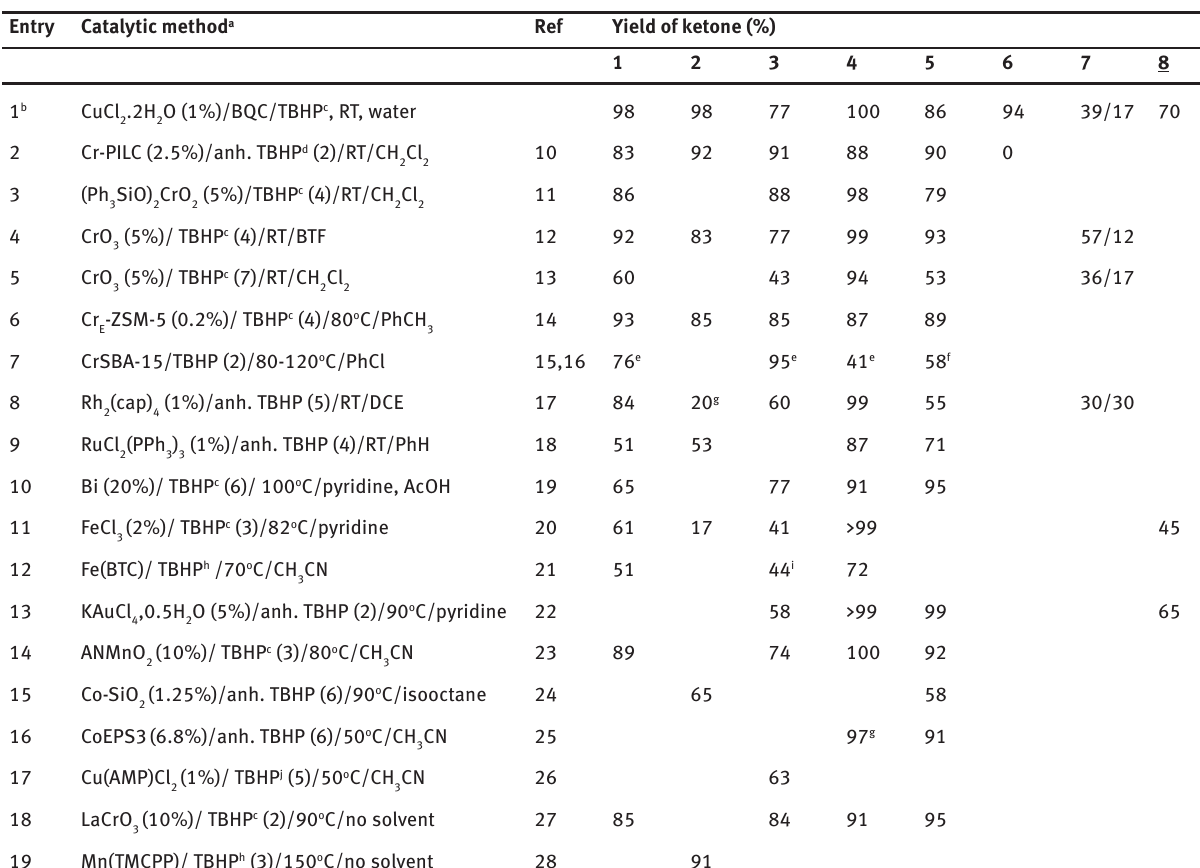
Table 4 : Oxidation of alkylarenes with TBHP: comparative data from various catalytic systems. Entry Catalytic method